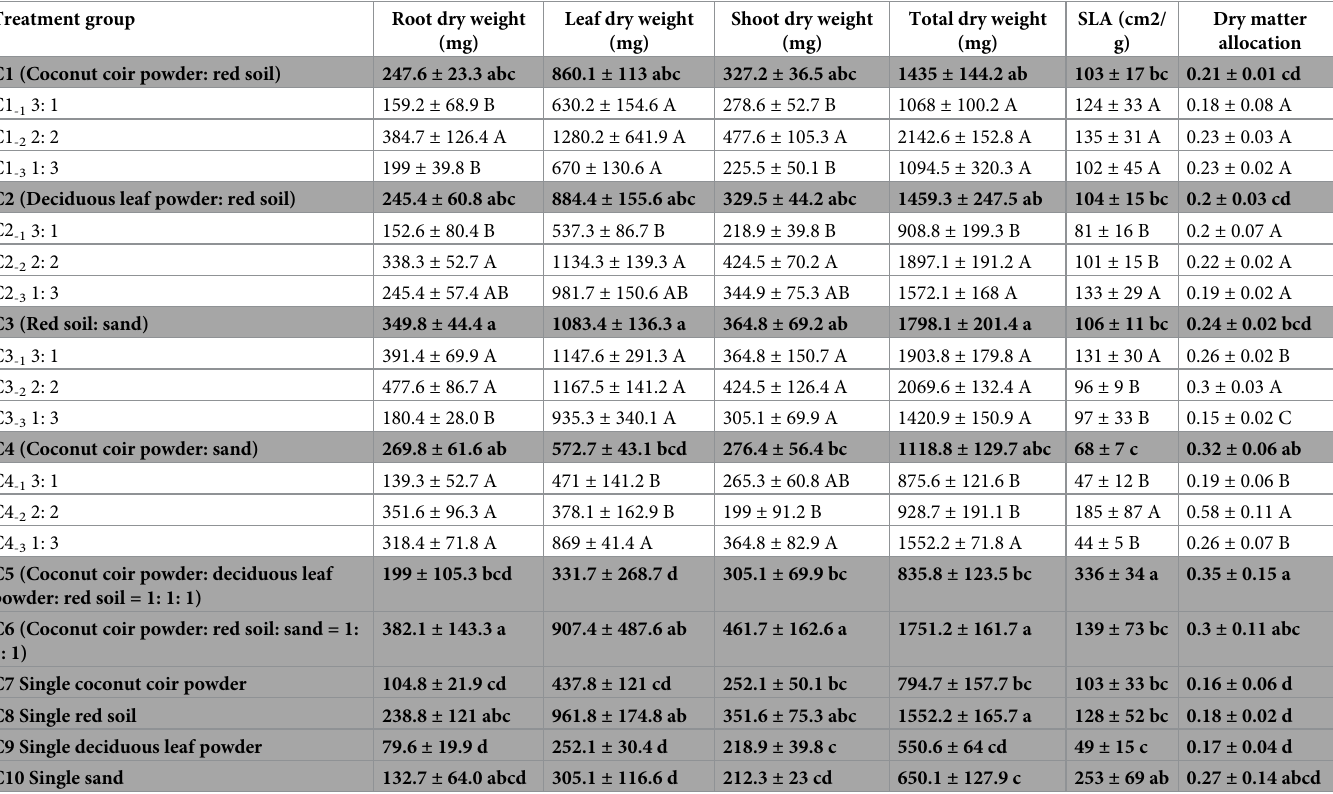
Table 3. Effect of substrate combinations and proportions on the biomass accumulation and allocation of D . odorifera seedlings. Different lowercase letters in the same column indicate the significant difference among different substrate combinations (P < 0.05). Different uppercase letters in the same column indicate the significant difference among the same substrate with different proportions (P <